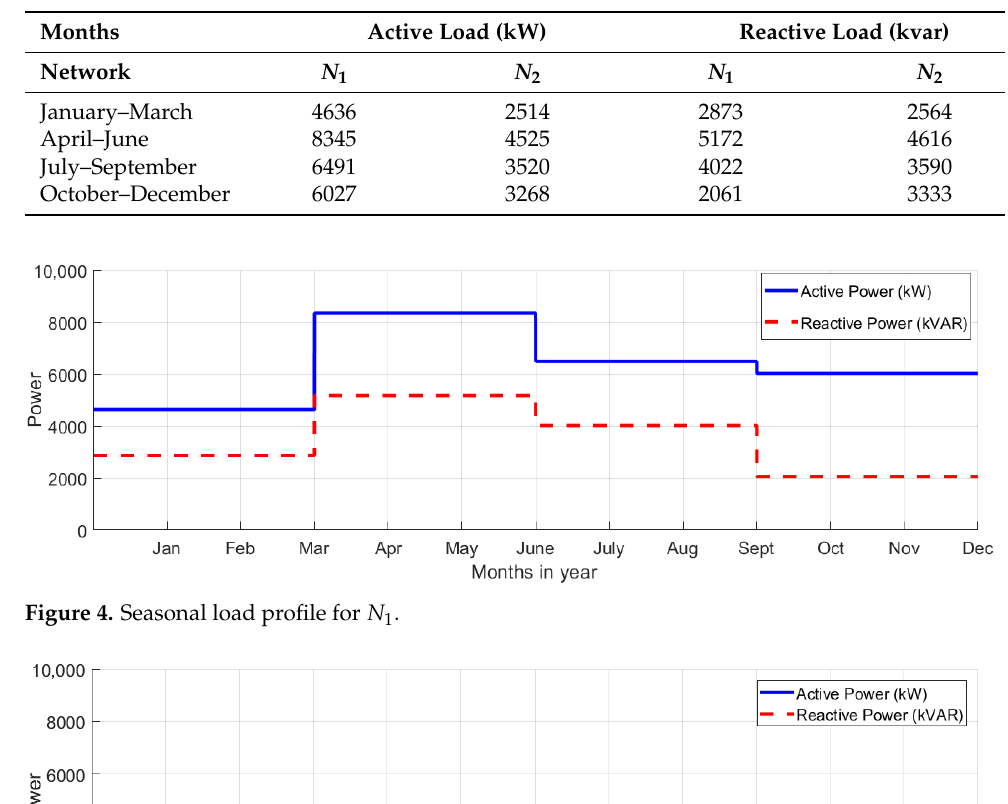
Table 1. Seasonal load profile for both networks.